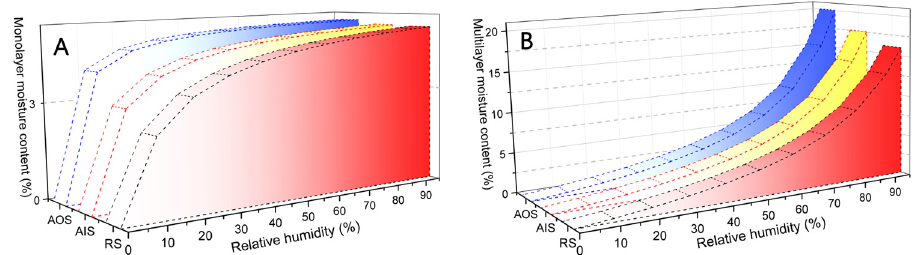
Figure 4. Moisture content at each relative humidity of the H-H model. Histogram for monolayer moisture content ( A ) and multilayer moisture content ( B ) at each RH.